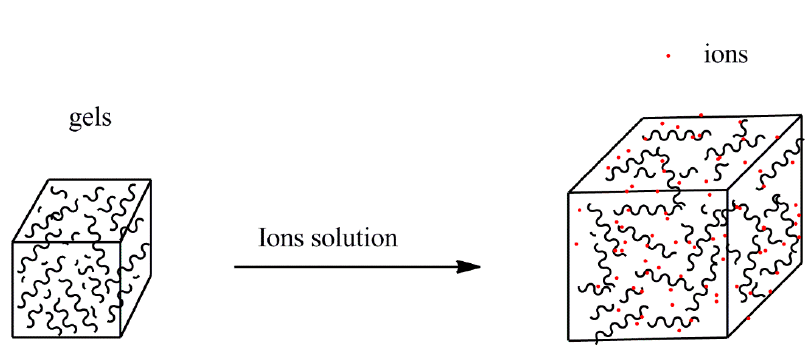
Figure 1. The simulation of the swelling of γ -PGA/ ε -PL hydrogels in ion solutions.